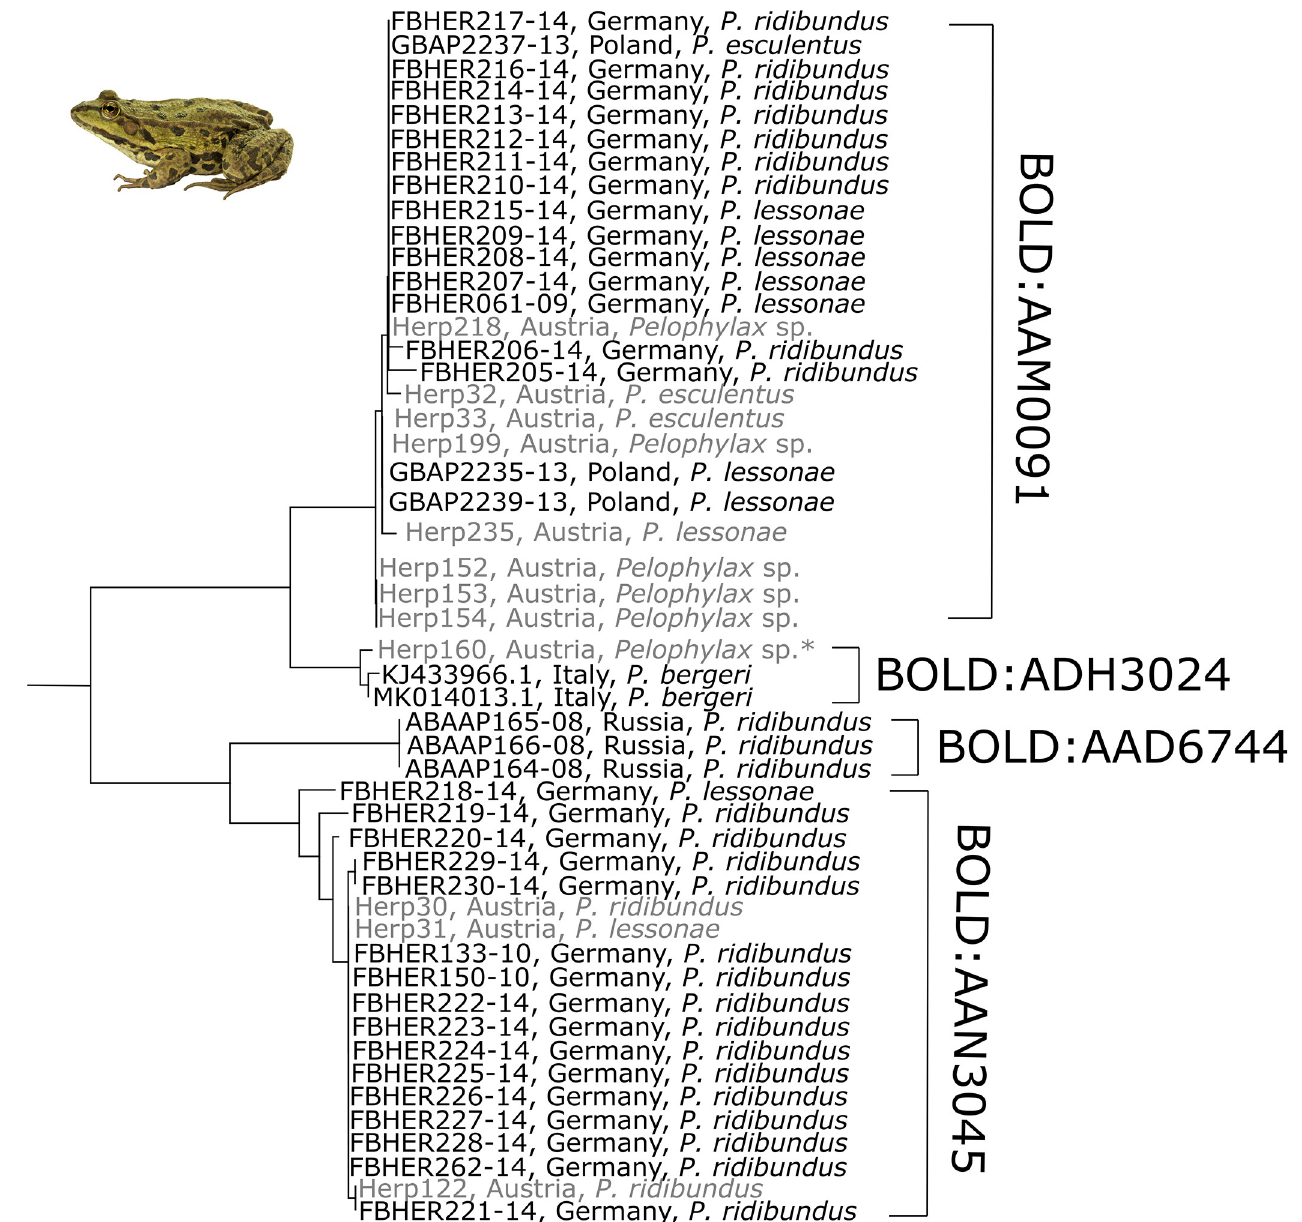
Fig 3. Subtree of the hybridogenetic Pelophylax species complex. DNA barcodes do not clearly resolve the two parental ( P . lessonae , P . ridibundus ) and the hybrid ( P . kl. esculentus ) species but provide evidence for a genetic signature of the Italian water frog ( P . bergeri ) in one Austrian water frog sample (marked with � ). Light gray labels represent samples processed in this study. lessonae sample. P . ridibundus from Russia formed a distinct clade and was also represented by an individual BIN (BOLD:AAD6744). Two sequences of Italian P . bergeri clustered together with one Western Austrian water frog sample in a distinct BIN (BOLD:ADH3024), indicating the presence of P . bergeri mtDNA in (western) Austrian water frogs. The second major clade of pan-European water frog COI sequences included a mixture of all three species occurring in